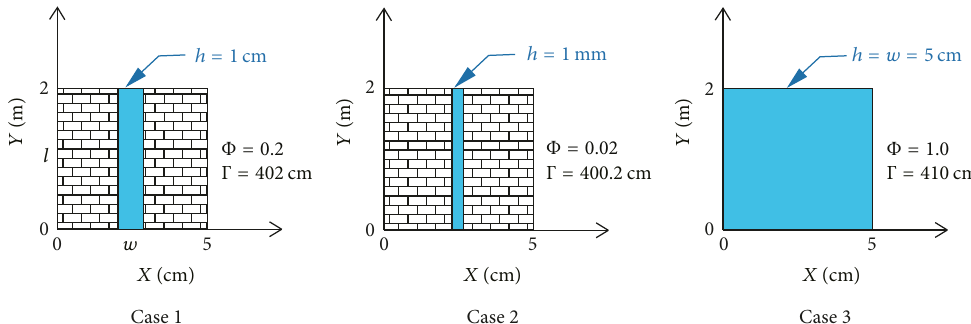
Figure2:Across-section( 𝑋𝑌 -plane)viewofthefracturezoneandrelationshipsofthefractureaperture, ℎ ,andperimeter, Γ ,andtheporosity, 𝜙 , of the fracture zone in different cases of various aperture sizes. Note that the cross-section of the fracture zone remains unchanged in our numerical grid (2 m in length, 𝑙 , and 5 cm in width, 𝑤 ) but the size of the virtual fracture (the blue colored area) can change and is defined by the perimeter of fracture space and the effective porosity of fracture zone and the ratio of fracture space over the total cross-sectional area of the fracture zone. In picture, the block-shaped area denotes the solid impermeable rocks in the fracture zone. In Case 1, a fracture of 1cm wide aperture would have a perimeter of 402 cm (2 × 200 + 2 × 1cm) and a porosity of 0.2 (1 × 200cm 2 /5 × 200 cm 2 ). The small aperture case ( ℎ = 1 mm) shown in Case 2 results in a porosity of 0.02 and perimeter of 400.2 cm. In particular, in Case 3, where a fracture fully develops among the fracture zone, its aperture finally equals the width of fracture zone of 5 cm, and the porosity becomes 1.0.